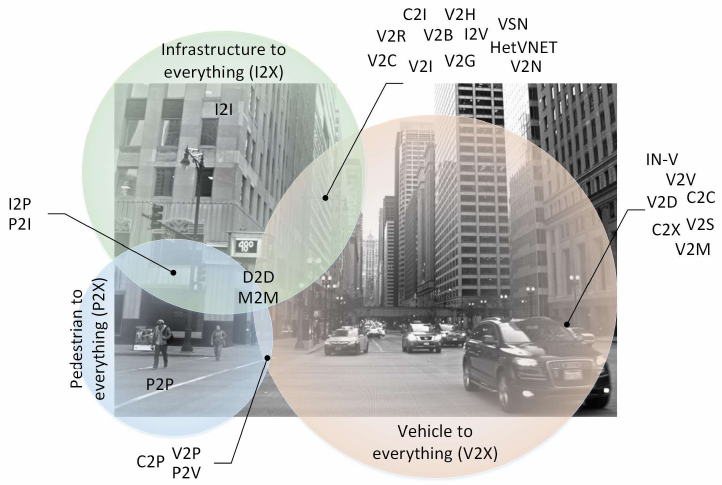
Figure 2. Diagram of interactions between vehicle, infrastructure, and pedestrian communications.